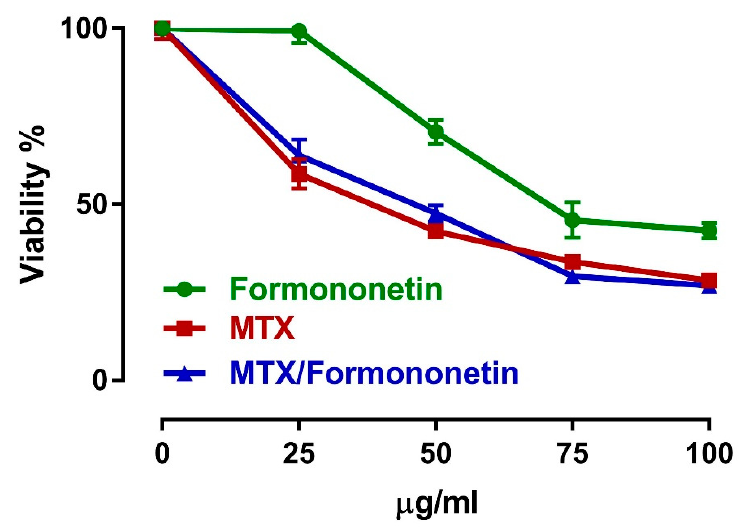
Figure 8. FN does not interfere with the antitumor activity of MTX. Treatment of HepG2 cells with either MTX or FN resulted in cytotoxicity. Per-treatment of HepG2 cells with FN did not interfere with the cytotoxic action of MTX. Data are mean ± SEM. The experiment was repeated three times ( N = 3).